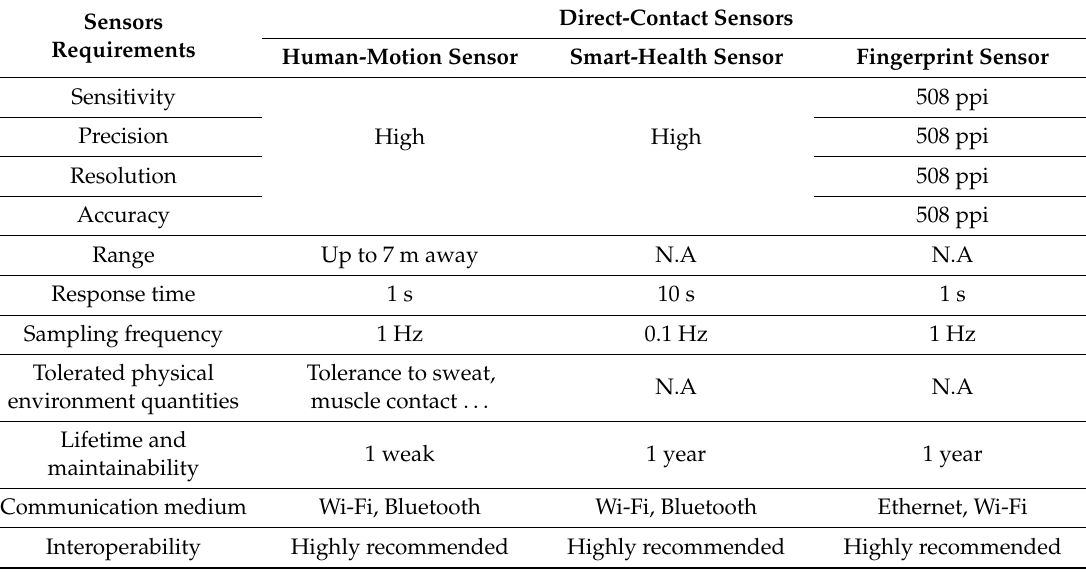
Table 3. High level requirements for direct-contact